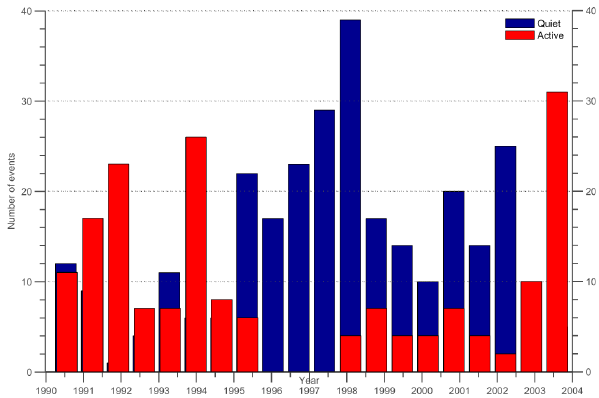
Fig. 1. Histogram of active (red) and quiet (blue) events.